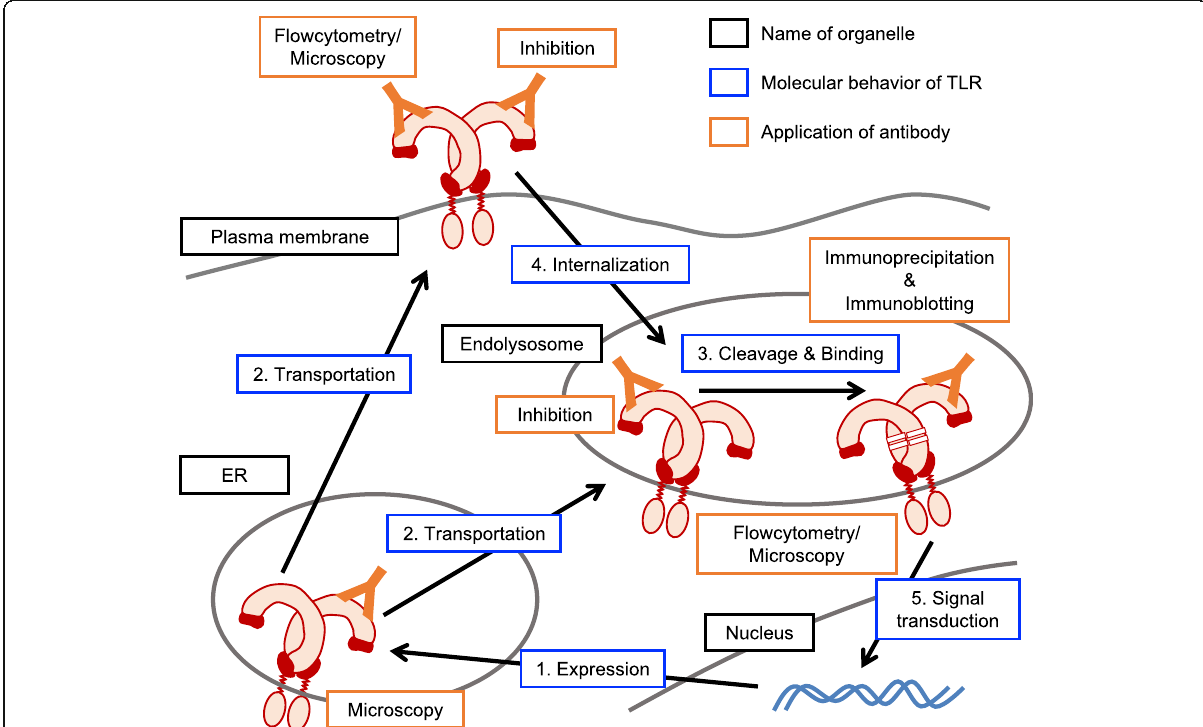
Fig. 2 Application of anti-TLR for the analysis of molecular mechanisms of TLR. Expressed TLRs are transported from ER to plasma membrane or endolysosome (1 and 2). In endolysosome, nucleic acid-sensing TLRs are cleaved and the N-terminal fragment binds to the C-terminal fragment (3). After the modification, TLR recognize ligand and signaling pathway is activated (5). TLRs on cell surface recognize ligand and activates signaling pathway. Some of them are internalized by the recognition of ligand or spontaneous trafficking (4). For the analysis of these molecular behaviors of TLR, monoclonal anti-TLR is well exploited. Amount and expression pattern among cell types are analyzed by flowcytometry. Subcellular distribution is observed by immunofluorescence microscopy. Alternatively, flowcytometry following the immunostaining with or without detergent is able to discriminate the distribution between cell surface and intracellular particle. Proteolytic cleavage and binding of nucleic acid-sensing TLR are detected by immunoprecipitation and immunoblotting. In addition to these application for detection, several antibodies have inhibitory effect on the response of TLRs. Words in black frames, blue frames, and orange frames are the name of organelle, the molecular behavior of TLR, and the application of anti-TLR,